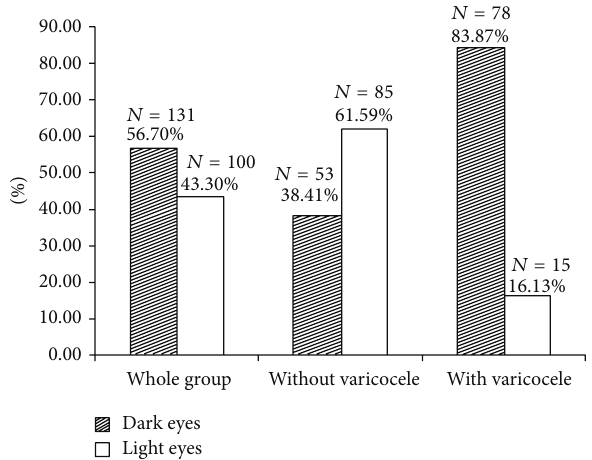
Figure 1: Percent of the men with dark and light eyes in the whole group and in patients with and without